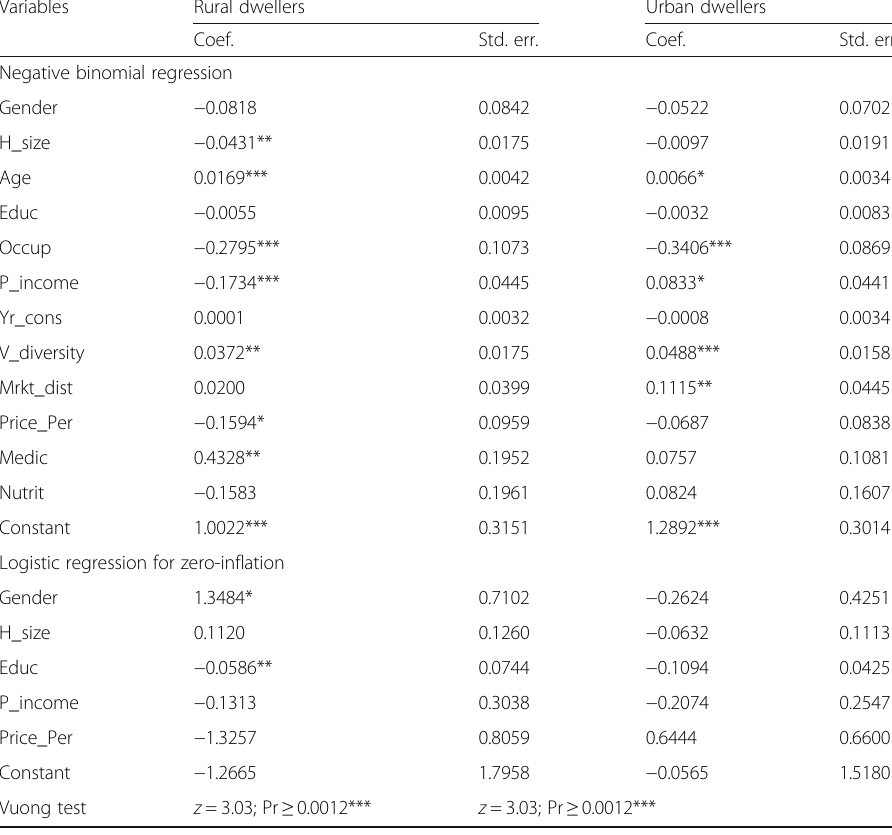
Table 5 ZIP model results on determinants of consumption intensity of leafy AIVs Variables Rural